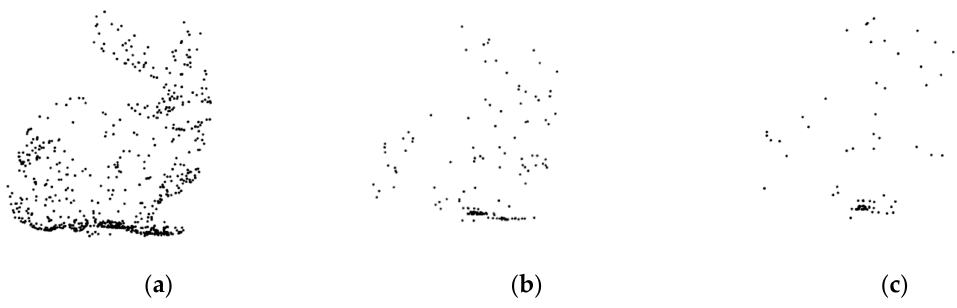
Figure 7. The key points for the curve surface feature : ( a ) θ = 718; ( b ) θ = 142; ( c ) θ = 70.